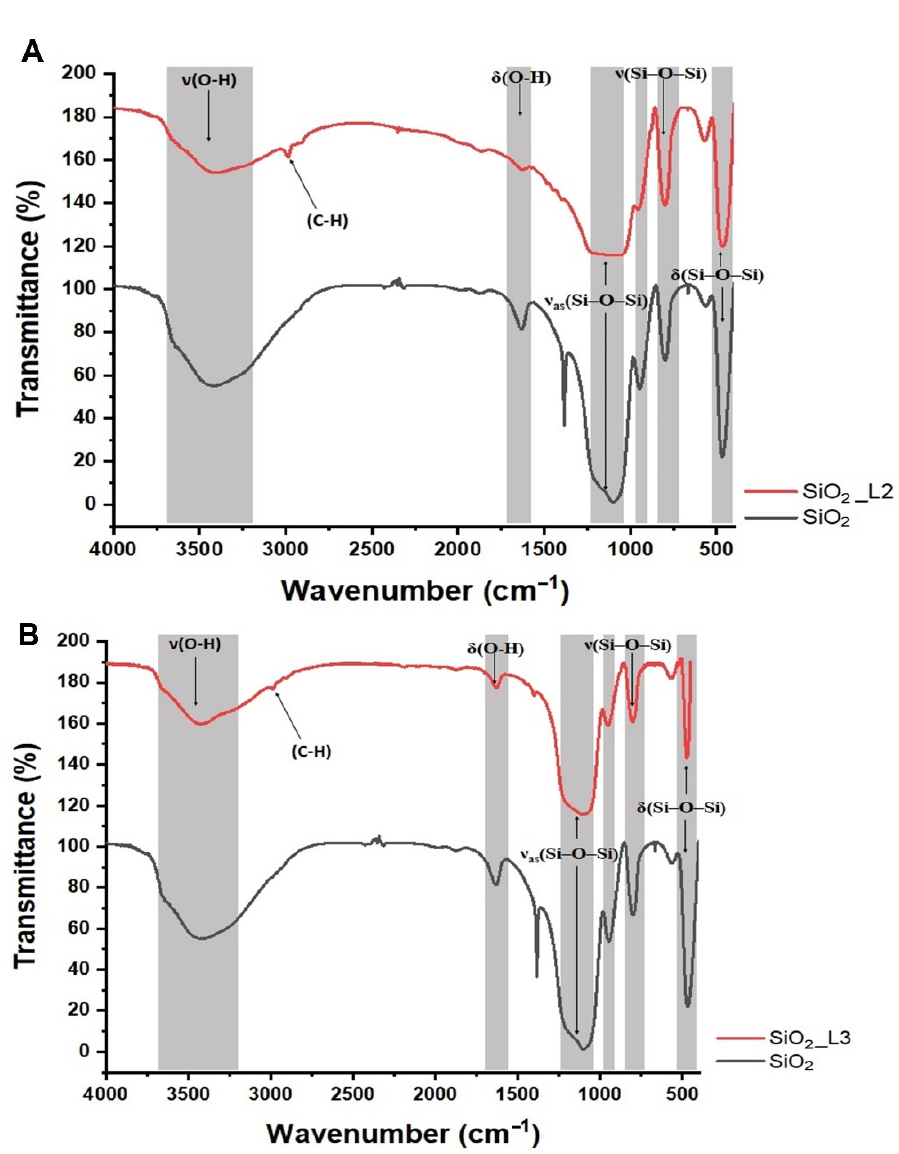
Figure 4. FTIR spectra of synthesized nanoparticles grafted with ( A ) L2 and ( B ) L3 ligands.